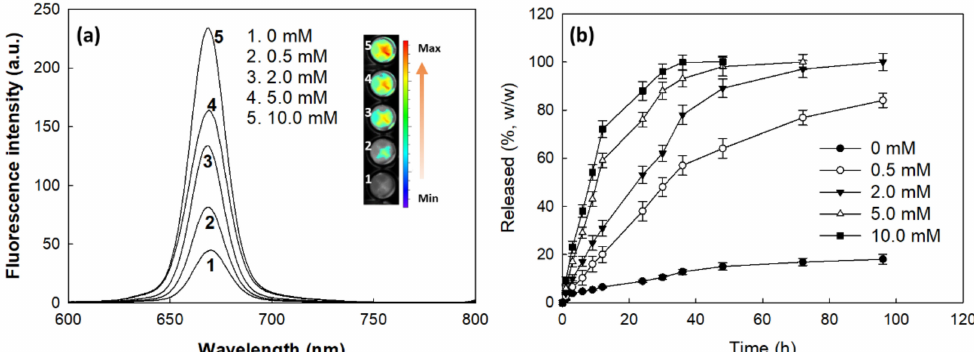
Figure 4. ( a ) The effect of H 2 O 2 on the changes in the fluorescence spectra of the nanophotosensitizers of the FaPEGbCD- seseCe6 conjugates. ( b ) The effect of H 2 O 2 on the Ce6 release from the nanophotosensitizers. The Ce6 concentration was adjusted to 0.1 mg/mL in PBS with or without H 2 O 2 . This solution was incubated for 4 h at 37 ◦ C to be reacted with H 2 O 2